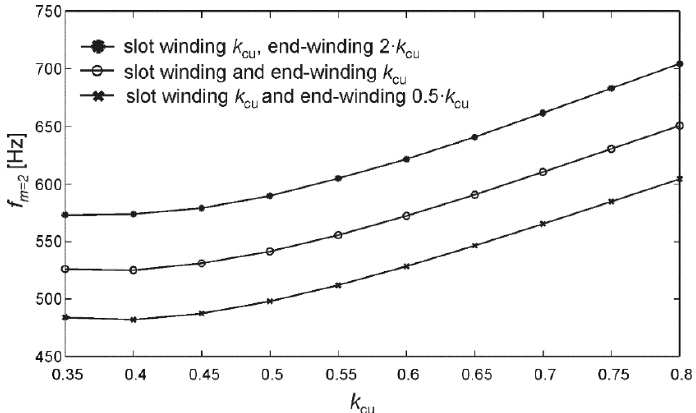
Figure 11. The numerically calculated dependency of the second modal natural frequency on the fill factor f m = 2 ( k cu ) for 1) the slot windings with k cu and end-windings with 2 · k cu ; 2) equal k cu is applied to both slot winding and end-windings; and 3) slot windings with k cu and end windings with 0.5 · k cu.